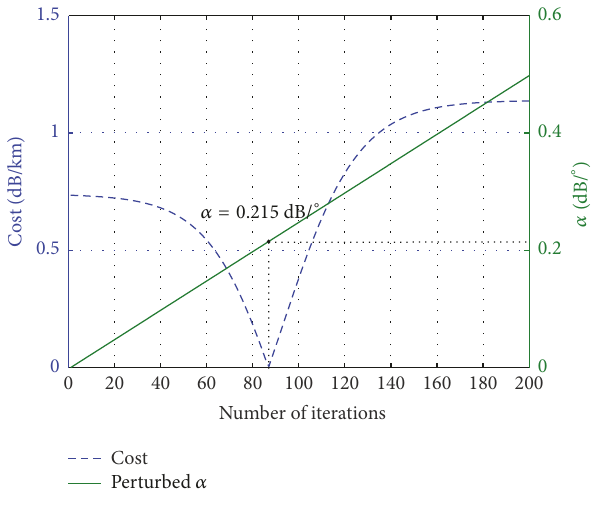
Figure 8: Distribution of the optimized 𝛼 for the case of 2 June 2015.